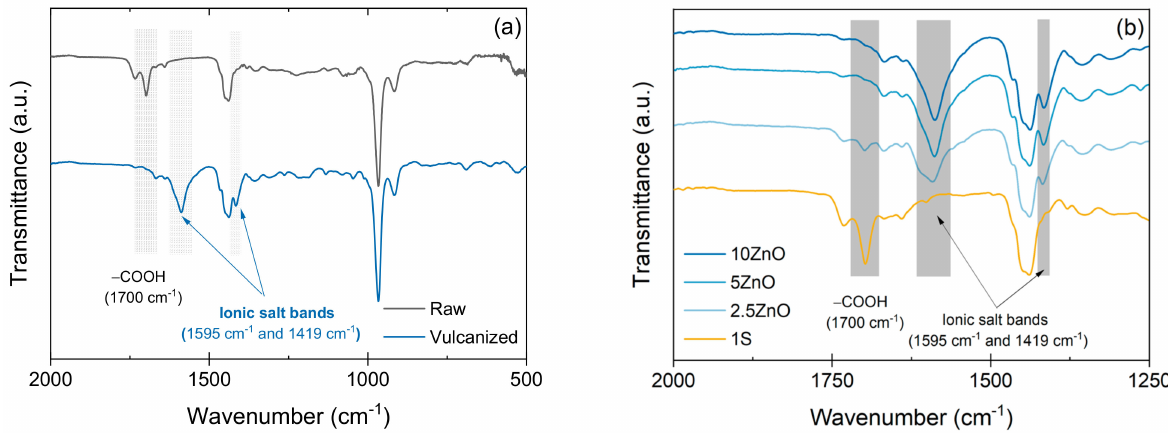
Figure 2. ( a ) ATR-IR spectra of raw and vulcanized 5 ZnO compounds; ( b ) ATR-IR spectra of covalent and ionic